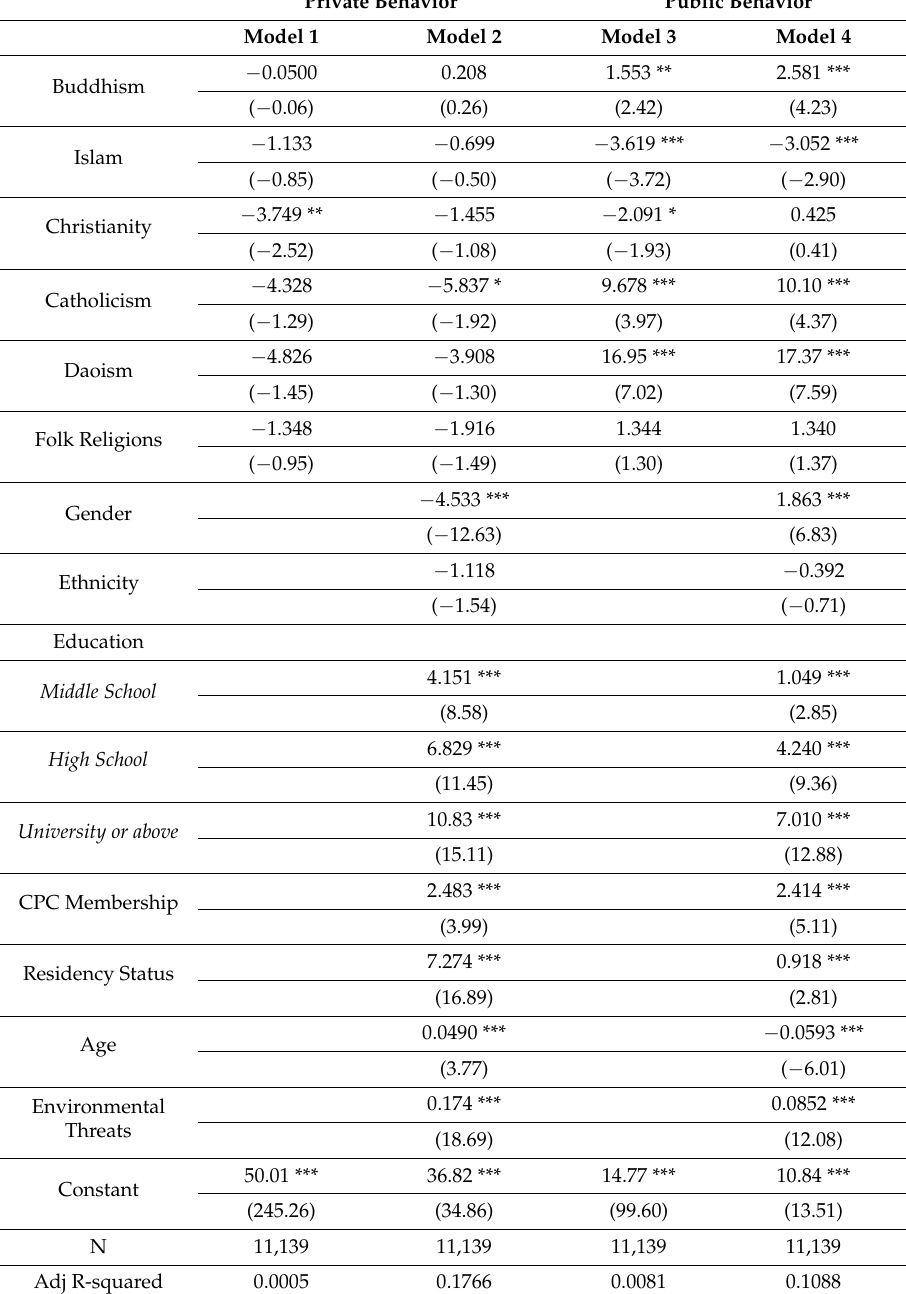
Table 4. Regression Results of Private and Public Environmental